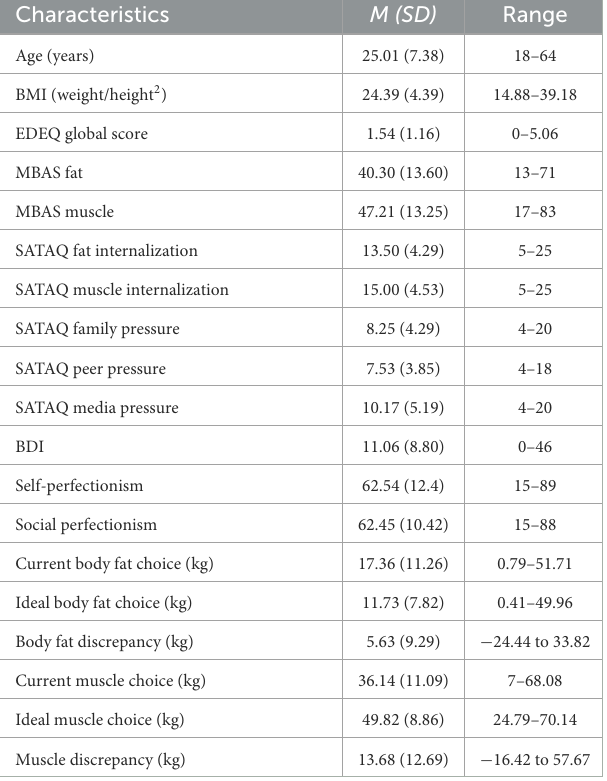
TABLE 1 Range, means and standard deviations showing participant characteristics and psychometric scores for the final sample ( N = 258). Characteristics M (SD)